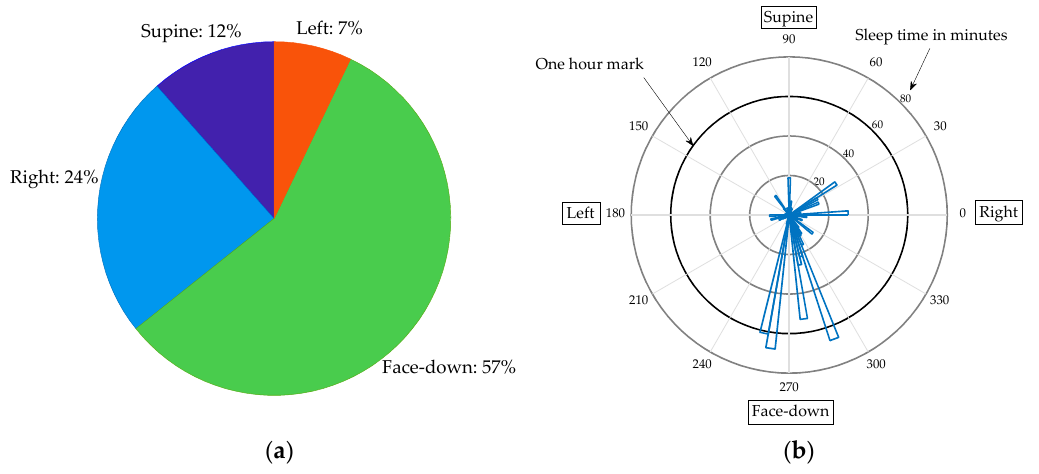
Figure 9. Summary of sleep position from a full night recording. ( a ) Percentage of time spent in each position. ( b ) A polar diagram showing sleep angle versus sleep time in minutes.